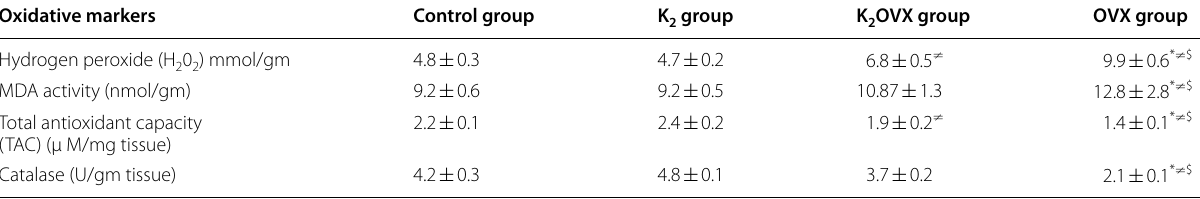
Table 2 Biochemical results in the studied